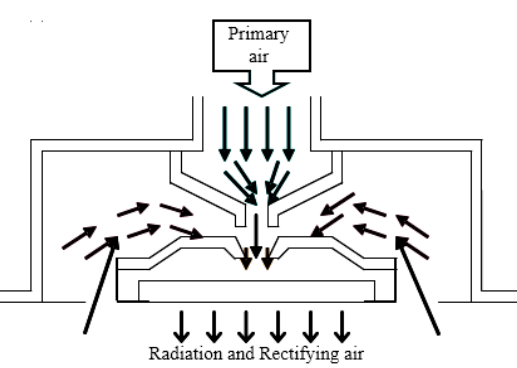
Figure 2. Cross-section of the RIDU.